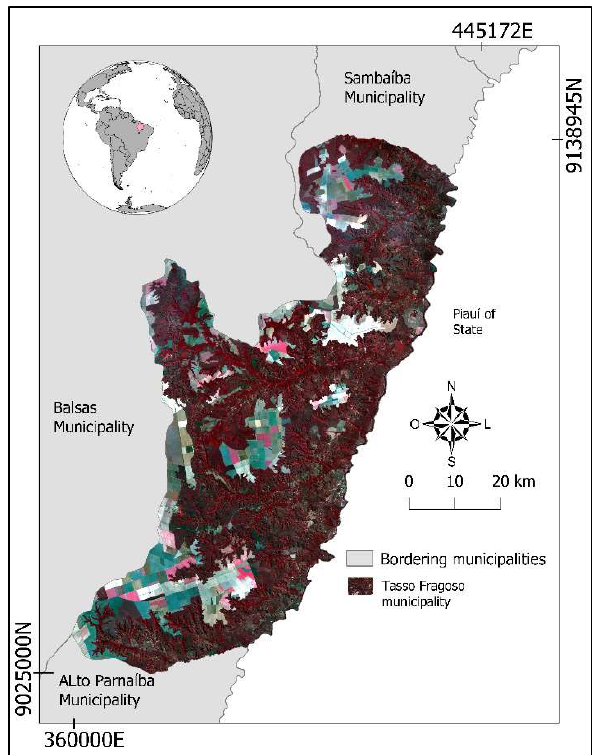
Figure 1 . Localization of Tasso Fragoso municipality – MA